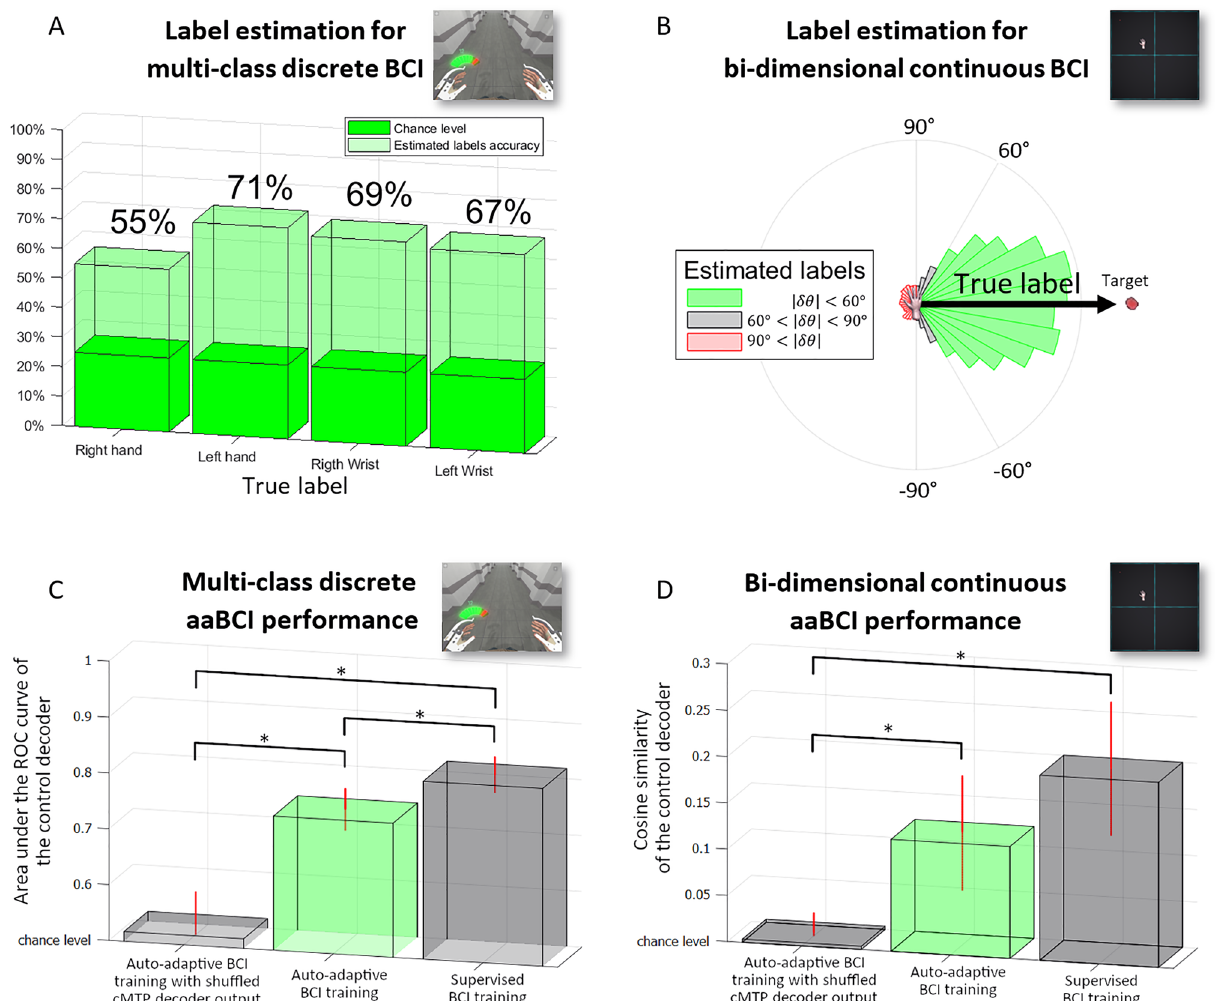
Figure 3. ( A , B ) Accuracy of the estimated labels in the datasets used for the training of the aaBCI control decoders. ( A ) Percentage of labels correctly estimated for each motor class for the discrete multi-class BCI. ( B ) Polar histogram of the angle between estimated control labels (using the aaBCI, (cid:31) y t control ) and the actual labels (the x and y Cartesian distance from the cursor to the target, y t control ). When labeling data for the cMTP decoder, epochs with angles between the movement performed ( (cid:31) y t control ) and the actual labels ( y t control ) that were higher than 90° were labeled as erroneous, epochs with angles lower than 60° were labeled as correct and epochs with anglens between 60° and 90° were discarded. ( C , D ) Comparison of the performance of the control decoder depending on its training method. Error bars represent standard deviations. Stars denote statistically significant differences (two-sided Wilcoxon–Mann–Whitney tests, p < 0.005). ( C ) In the multiclass discrete BCI paradigm, performances were evaluated using the multi-class generalization of the area under the curve (AUC) of the receiver operating characteristic curve. ( D ) In the bi-dimensional BCI paradigm, performances were evaluated using the cosine similarity between decoded and optimal cursor